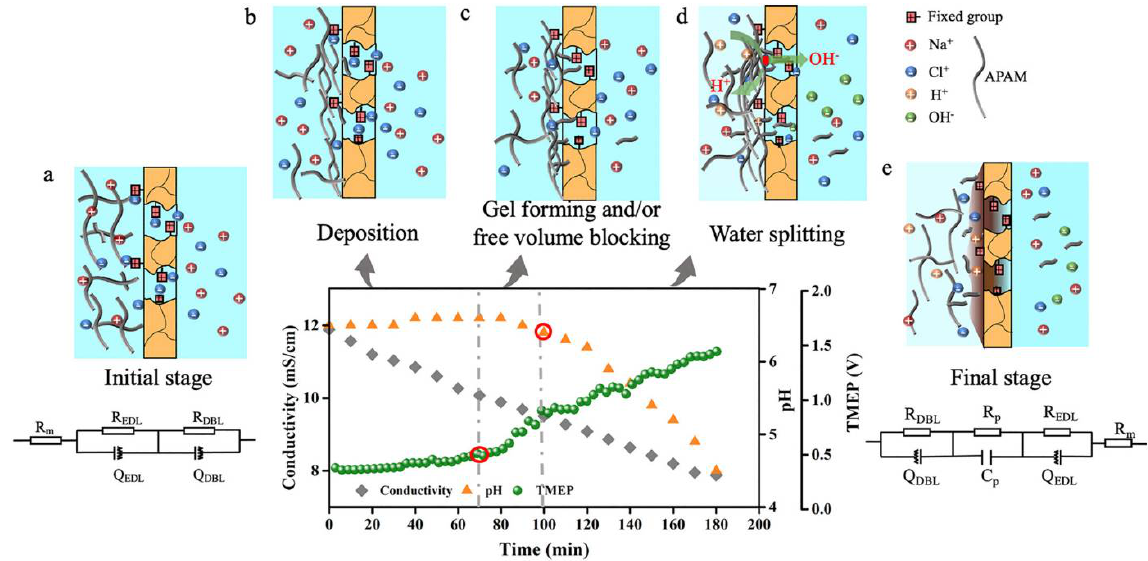
Figure 36. Mitigation of APAM fouling in ED [164].